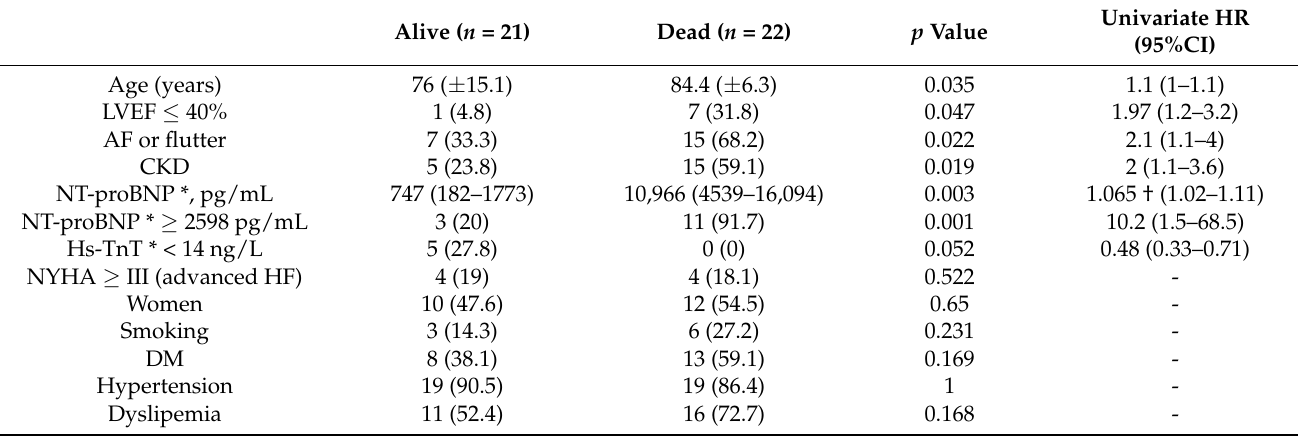
Table 6. Predictors of death in CHF